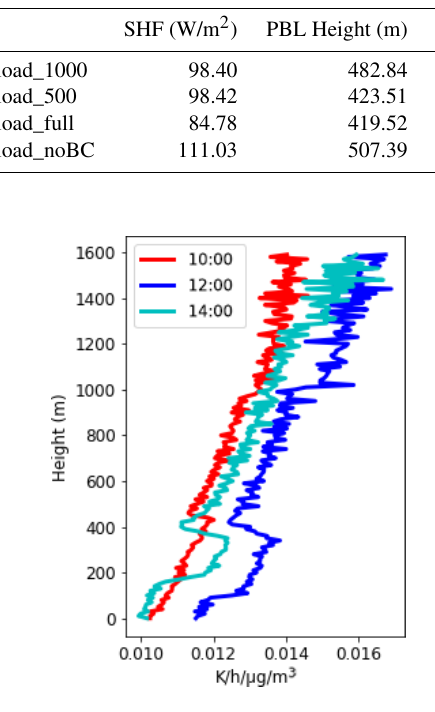
Figure 10. SW heating rate per unit mass of BC at 10:00, 12:00 and 14:00 on 3 December for simulations with BC throughout the